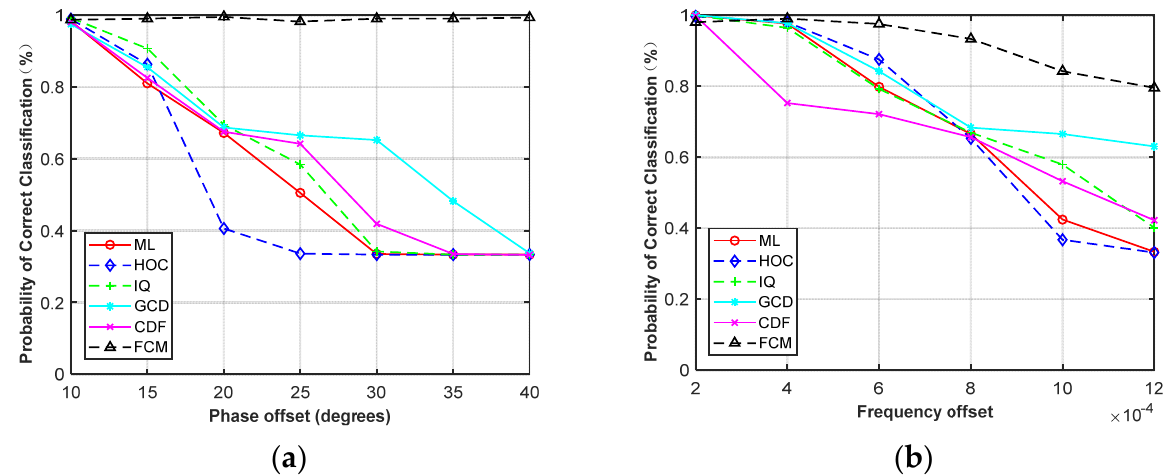
Figure 17. Probability of correct classification of MPSK (SNR = 6, N = 128) versus phase offset ( a ) and frequency offset ( b ).